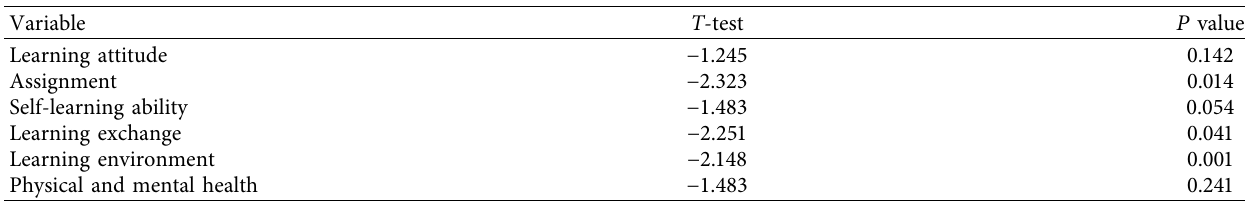
Figure 2: The composition of factors influencing learning adaptability based on the combination of theoretical combing and interviews. Table 1: Scaling